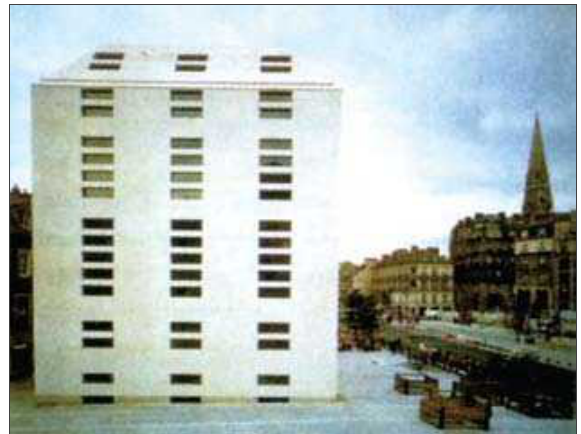
Fig. 21. La Perouse hotel, Nantes,